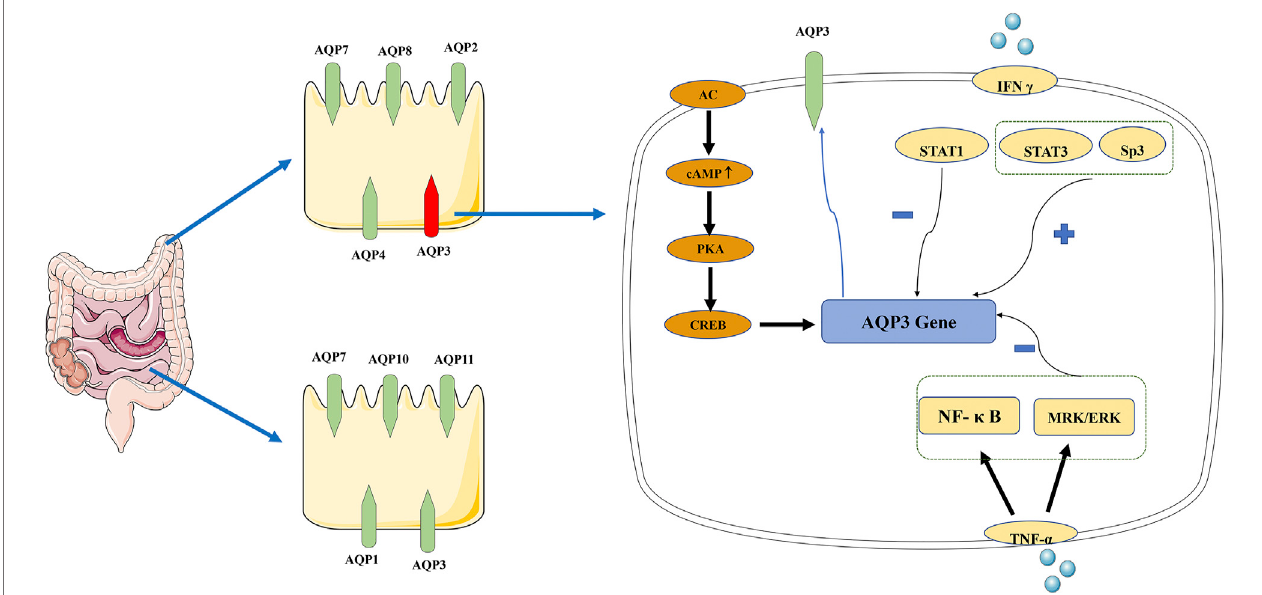
FIGURE 4 | Distribution of AQPs in intestinal tract and signal transduction mechanism of AQP3. AQP1, AQP3, AQP7, AQP10, and AQP11 are highly expressed in thesmallintestine, whileAQP2,AQP3,AQP4,AQP7,and AQP8arethemainsubtypes inthecolon. “ + ” indicate apromotingrole, “ − ” indicate aninhibition role.InAQP3 expression, there are two pathways: AC-mediated short-time regulation and long-term regulation at the transcriptional level. AC, adenylate cyclase; AQP, aquaporin; cAMP, cyclic adenosine monophosphate; CREB, cAMP response element-binding protein; PKA, protein kinase A; TNF- α , tumor necrosis factor alpha.